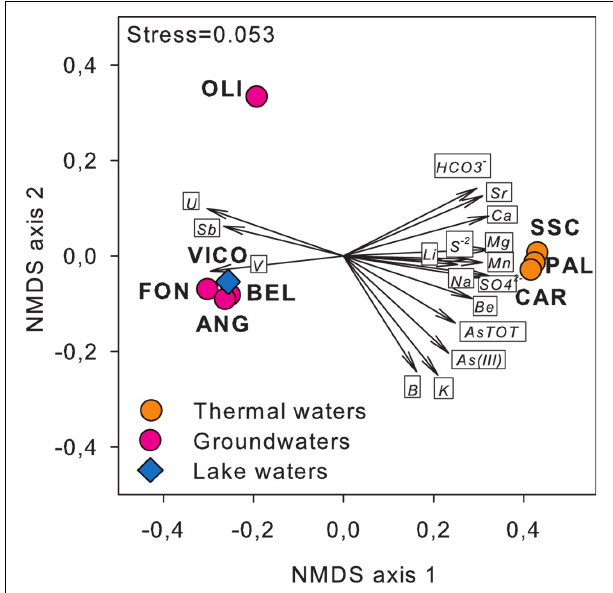
FIGURE 1 | NMDS ordination plot, based on Euclidean distance matrix of log-transformed data, showing the variation patterns of chemical variables that varied significantly between thermal and non-thermal waters. The vector length is proportional to the correlation between the NMDS axes and each chemical variable. The stress value (i.e., < 0.2) suggests for an accurate representation of the dissimilarity among water samples.